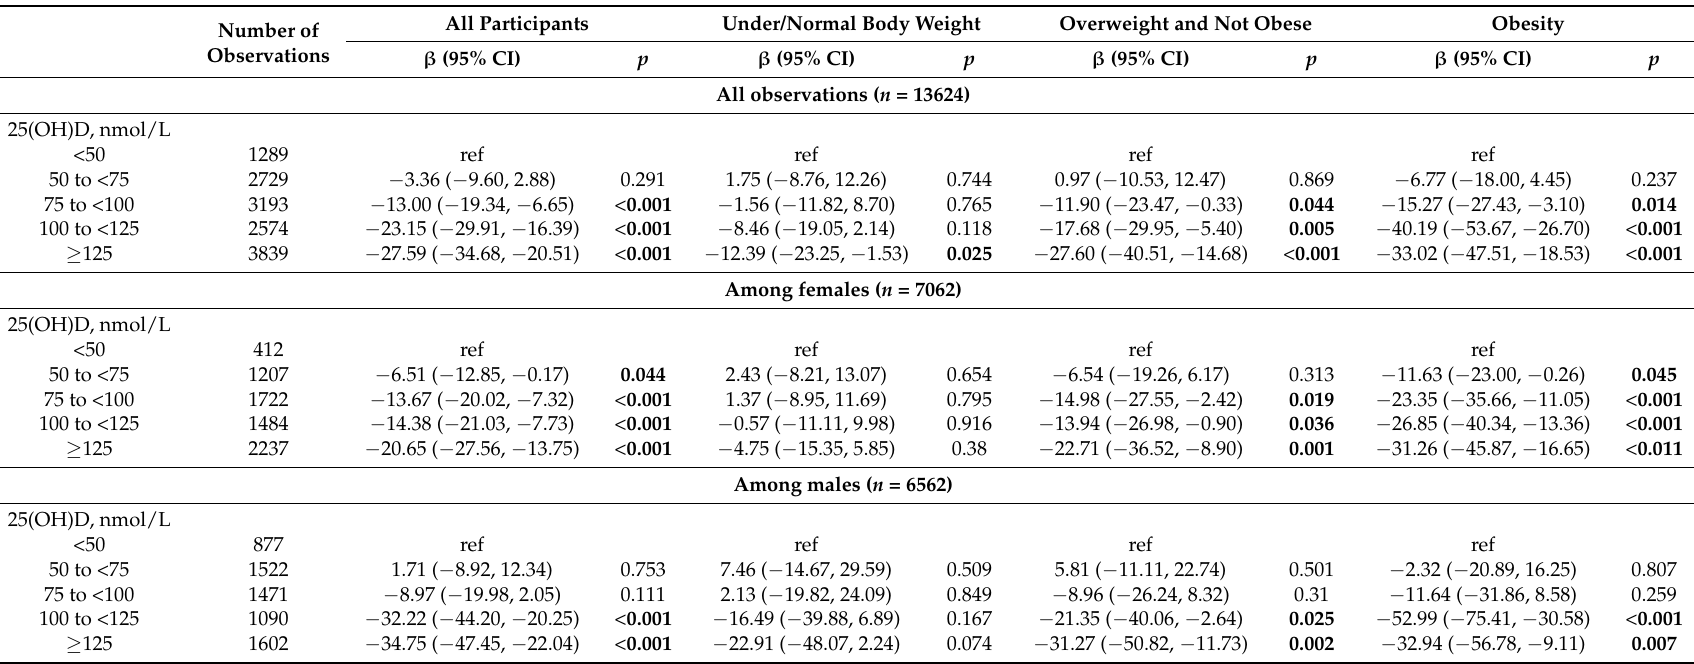
Table 3. Cross-sectional associations of serum 25(OH)D and serum ferritin concentrations at baseline and follow-up. All Participants Under/Normal Body Weight Overweight and Not Obese Obesity Number of Observations β (95% CI) All observations ( n =